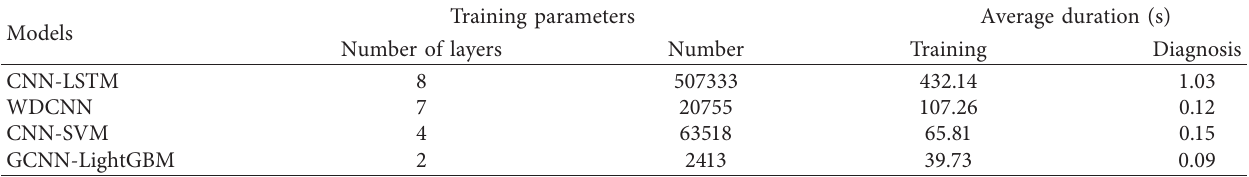
Table 5: Analysis table of training time and diagnosis time of each